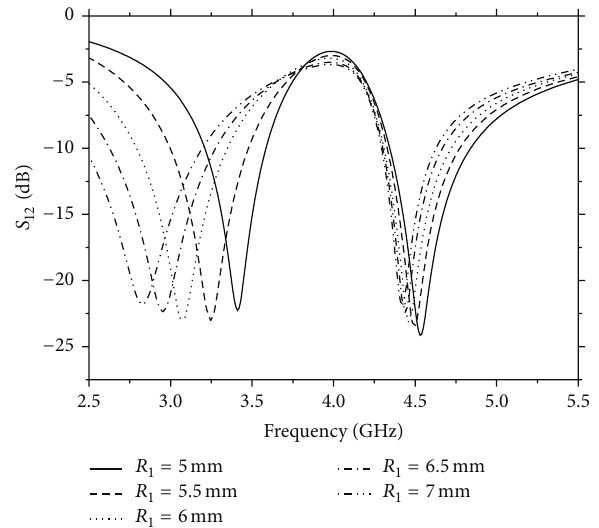
Figure 3: The transmission coefficient of the filter with variation of 𝑅 1